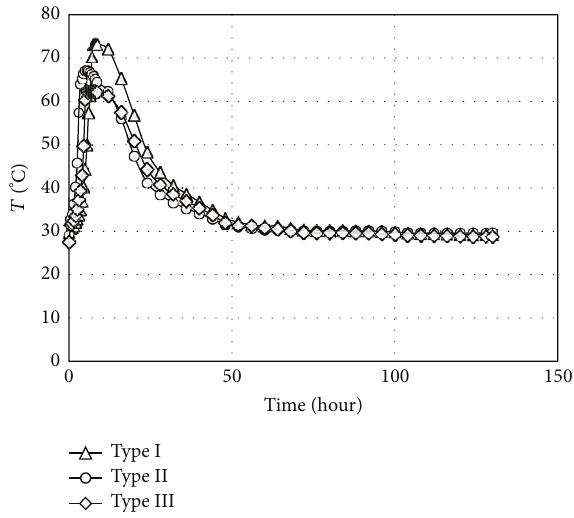
Figure 4: Development of heat of hydration.